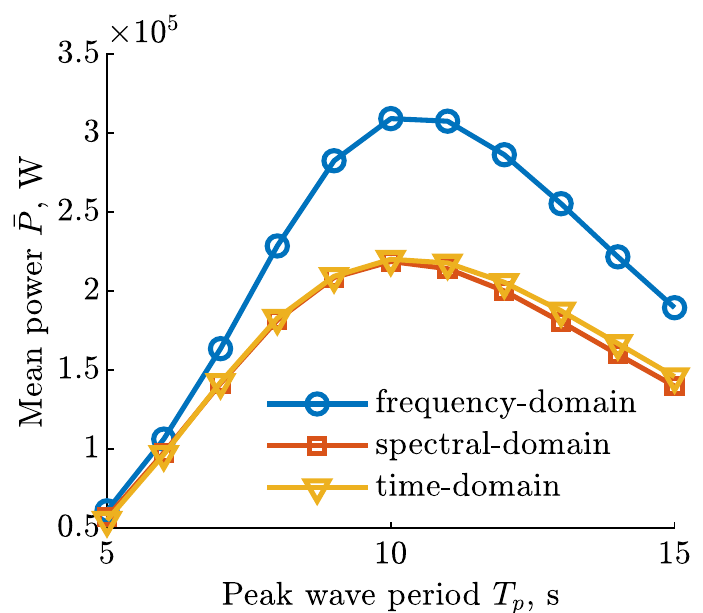
Figure 3. Power production of a three-tether WEC in irregular waves estimated using three different models: frequency-, spectral-, and time-domain. Parameters of the WEC are a = 5.5 m, H = 5.5 m, α ap = α t = 45deg, K pto = 200 kN/m, B pto = 150 kN/(m/s)), irregular waves have the